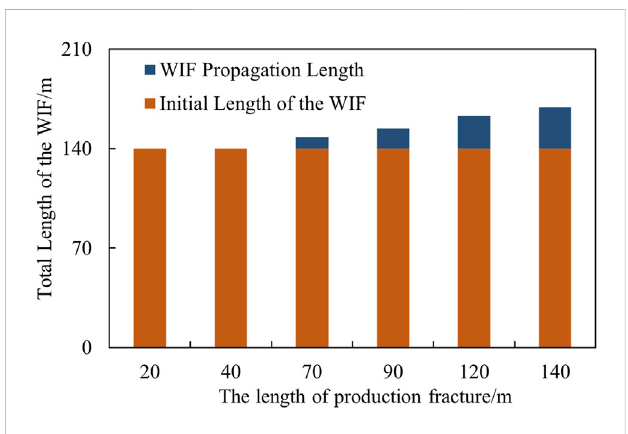
FIGURE 9 Effects of the initial length of the production fracture length on the WIF propagation.